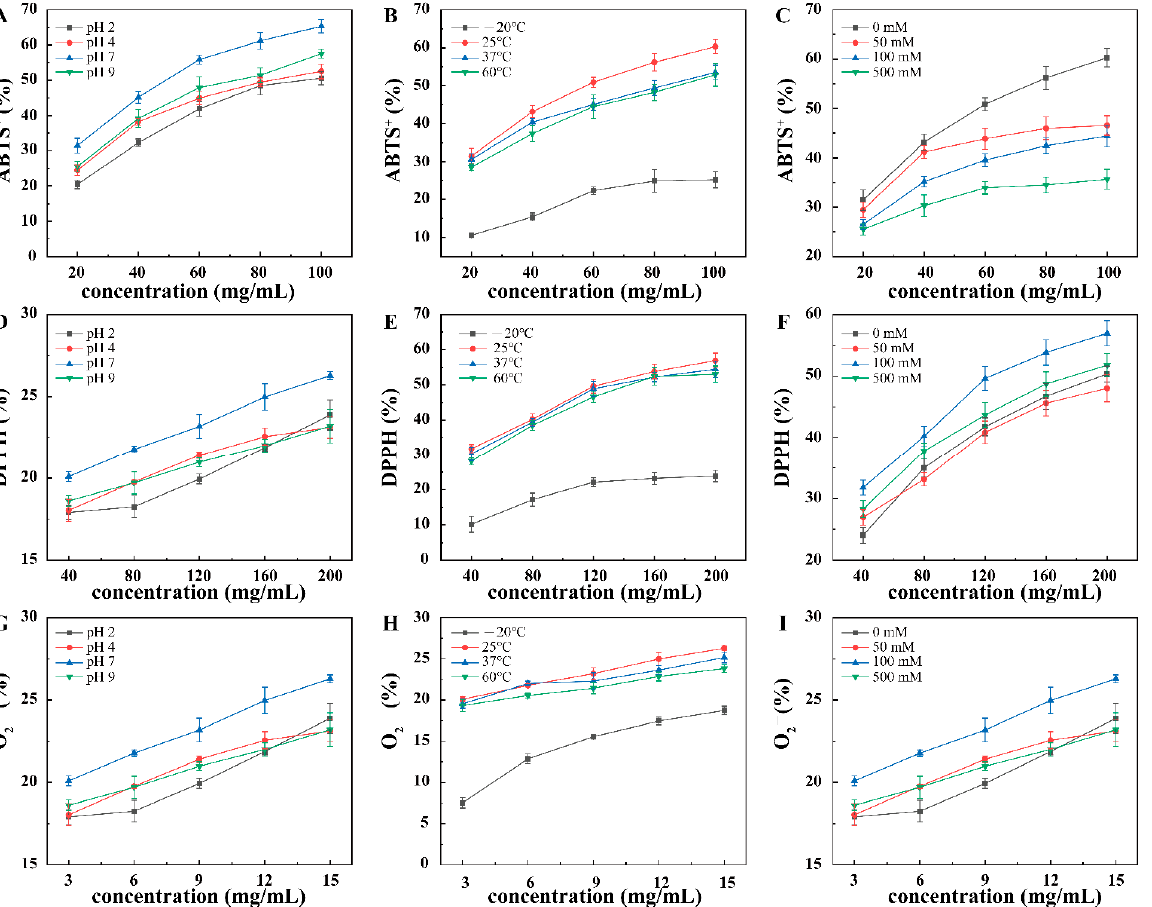
Figure 6. Antioxidant activities of the Pickering emulsion under different environmental